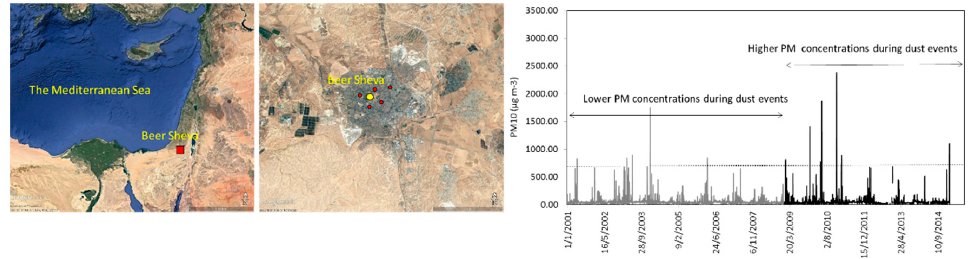
− 3 ) over the last